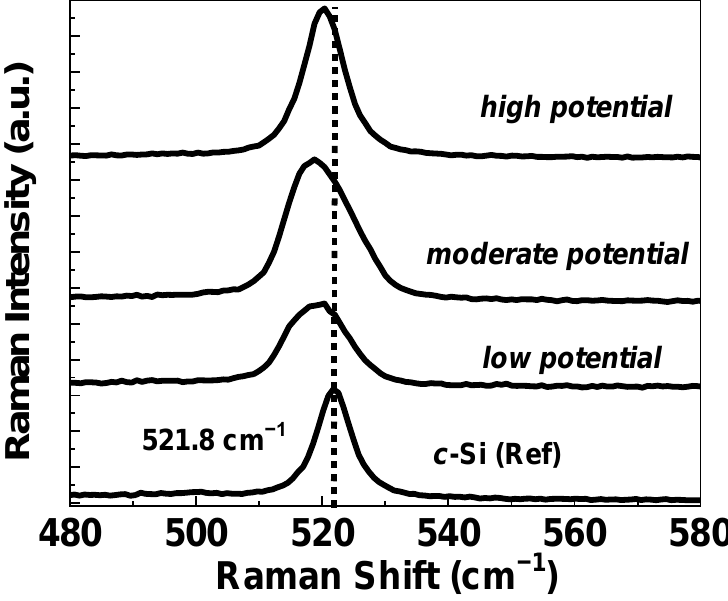
Figure 7. Raman spectra of electrodeposited Si-layers obtained at various reduction potentials.